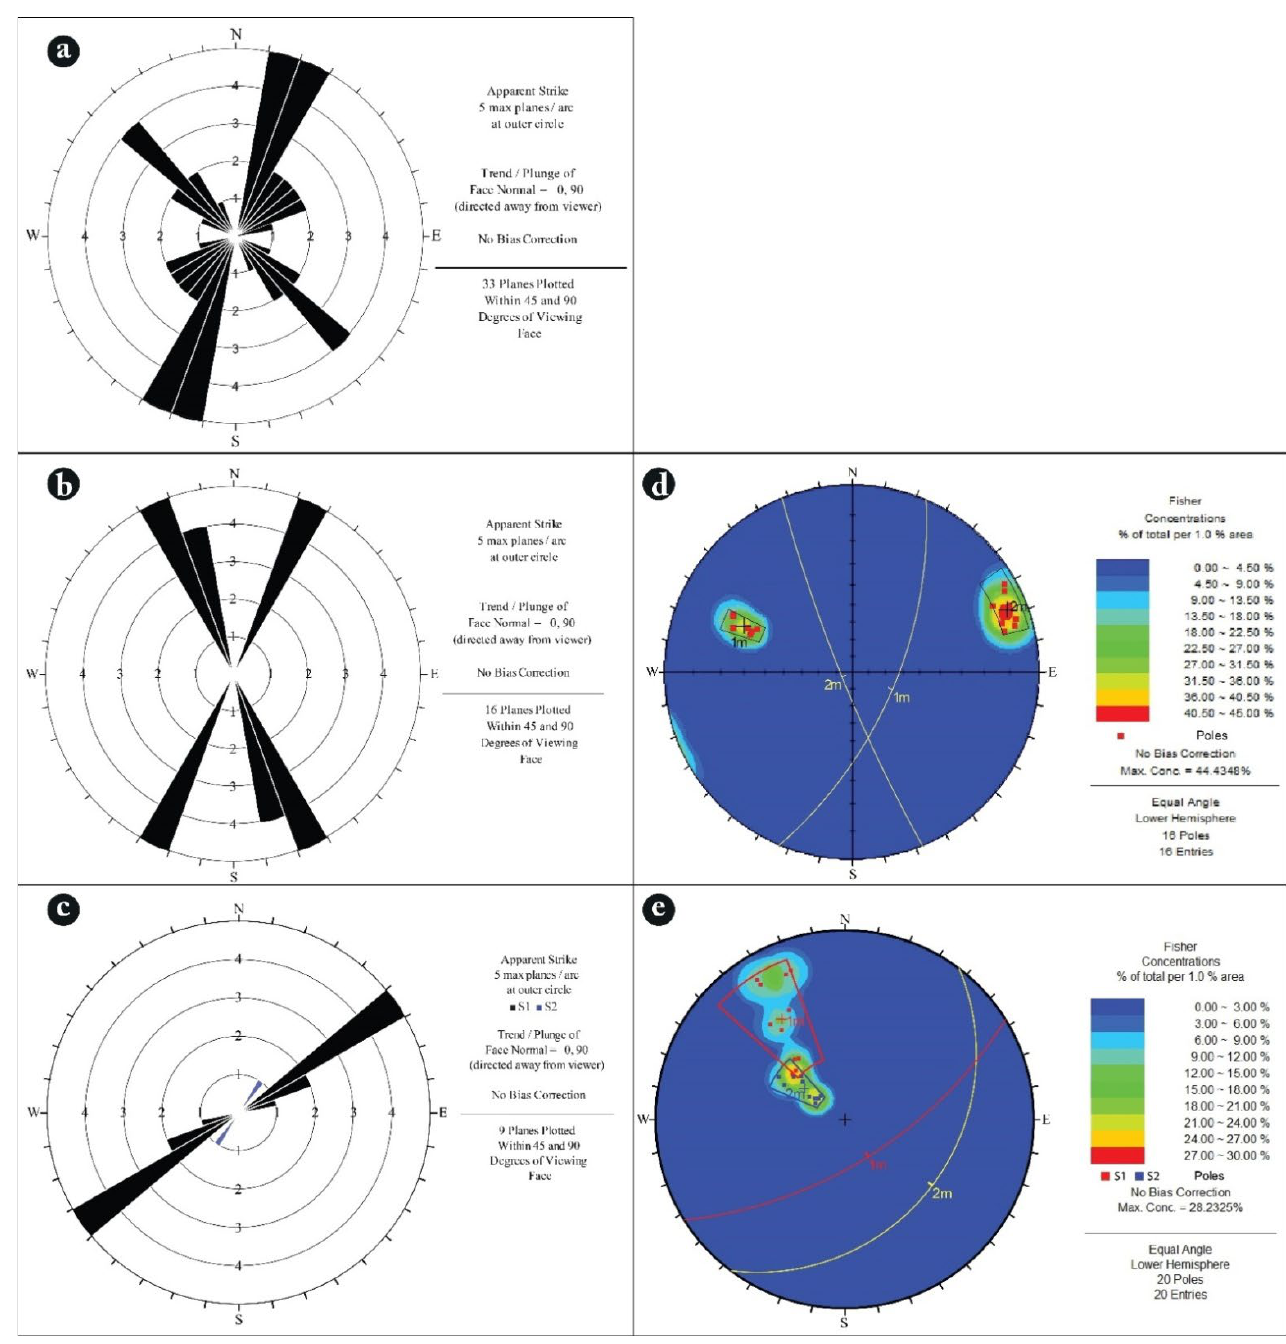
Figure 7. Directional rise in the NNE Achemmachof fault families ( a ) and fold families ( b , c ), and S1–S2 schistosity pole stereograms ( d , e ).